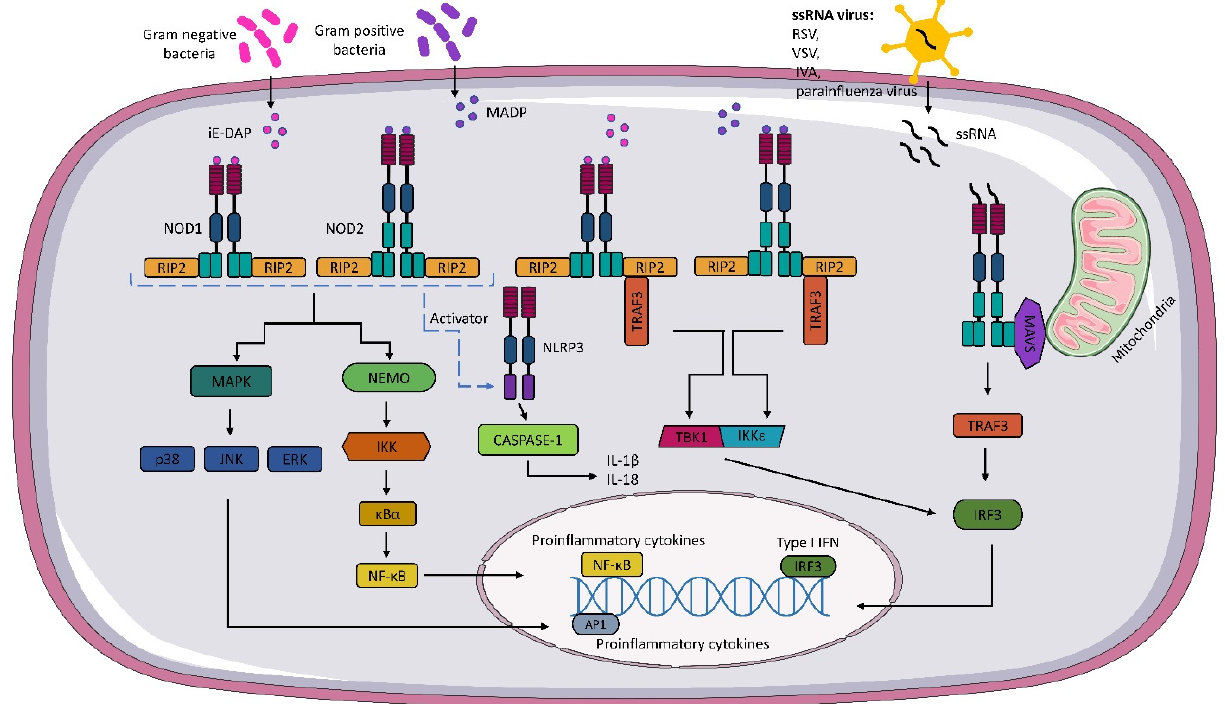
Figure 1. NOD1 and NOD2 signaling pathway. Gamma-glutamyl diaminopimelic acid (iE-DAP) and muramyl dipeptide (MDP) activate the nucleotide-binding oligomerization domains 1/2 (NOD1) and (NOD2), respectively. Activation of NODs leads to the recruitment of receptor-interacting serine/threonine kinase (RIP2). In the next step, activated RIP2 can lead to ubiquitination of the essential modulator of NF- κ B (NEMO) and activation of the IKK (I κ B kinase) complex. The activated IKK complex phosphorylates the inhibitor of kappaB (I κ B α ). The activated IKK complex phosphorylates the kappaB inhibitor (I κ B α ), leading to the release of NF- κ B, which, after translocation to the cell nucleus, binds to kappaB ( κ B) elements, thereby activating pro-inflammatory cytokines. NOD1 and NOD2 also activate mitogen-activated protein kinases (MAPKs), such as p38, c-Jun N-terminal kinase (JNK), and extracellular signal-regulated kinase (ERK). NOD1 and NOD2 also interact with the NLRP3 inflammasome, which leads to caspase-1 activation and IL-18 and IL-1 β production. Activation of NOD1 and NOD2 results in the formation of a TBK1 and the inhibitor of the nuclear factor kappaB kinase (IKK ε ) complex, which leads to the expression of type I IFNs. As well, through the interaction of NOD2 with mitochondrial antiviral signaling protein MAVS, the expression of IFN I genes occurs.